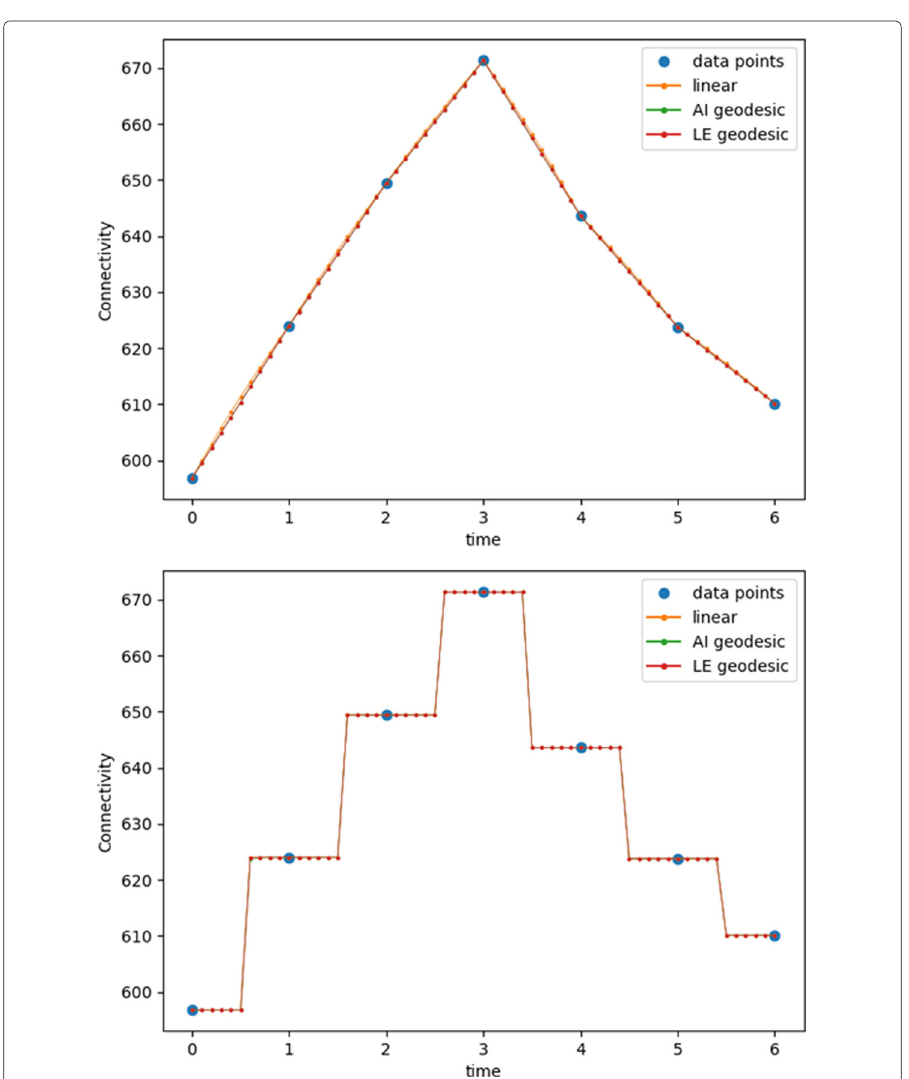
Fig. 4 Logarithm of product of non-zero eigenvalues over time, synthetic graphs. The connectivity results are shown for the interpolations that do not use a threshold ( top ) and the interpolations that use a threshold of 0.5 ( bottom